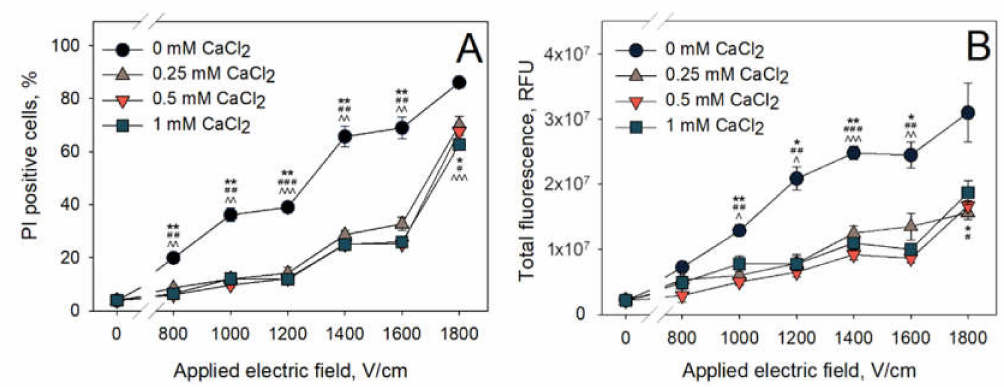
Figure 2. Dependence of PI electrotransfer e ffi ciency ( A ) and total cell fluorescence ( B ) of the treated cells on the applied electric field strength at various CaCl 2 concentrations. Cells were treated using 1 square HV pulse at a 100- µ s pulse duration. PI fluorescence was measured 15 min after electric field application. The statistical di ff erences between PI uptake (PI positive cells and total fluorescence) between control (0 mM CaCl 2 concentration) and 0.25, 0.5, 1 mM CaCl 2 concentrations are denoted by *, # and ˆ, respectively. One symbol denotes p < 0.05, two symbols— p < 0.01, three symbols— p < 0.001. The error bars represent the mean ± standard error of mean of n = 6 experimental